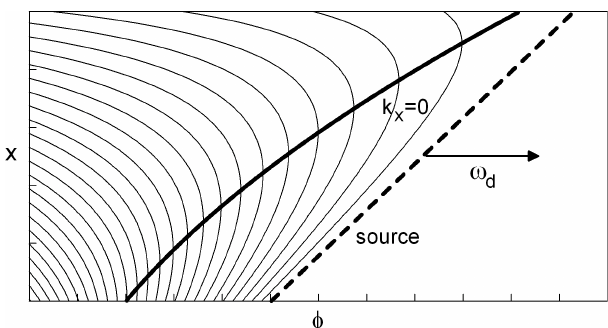
Fig. 8. Lines of constant modelled wave phase. The dashed line represents the drifting source (energetic particle cloud), positive φ is in the direction of the drift (westward for protons, eastward for electrons). The bold line corresponds to k x = 0 (a purely poloidal polarization of the